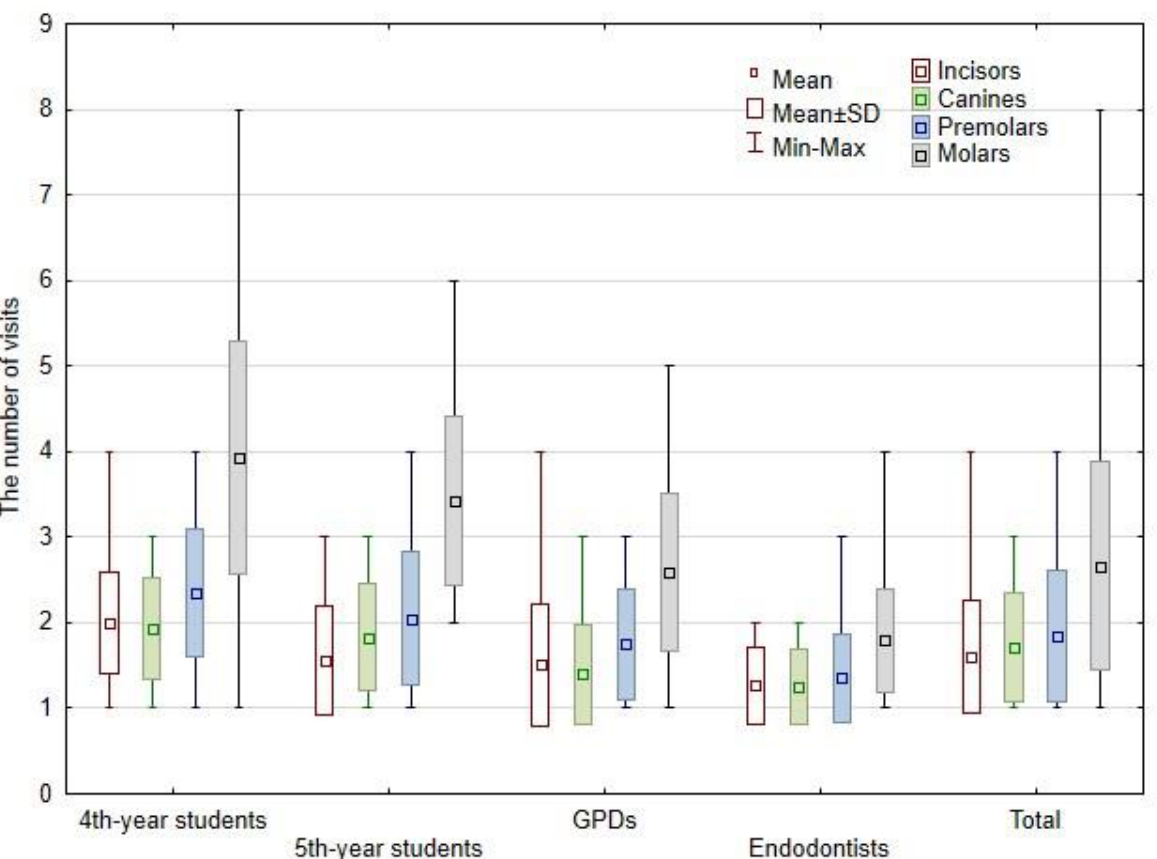
Figure 3. The mean value of number of visits in evaluated groups.